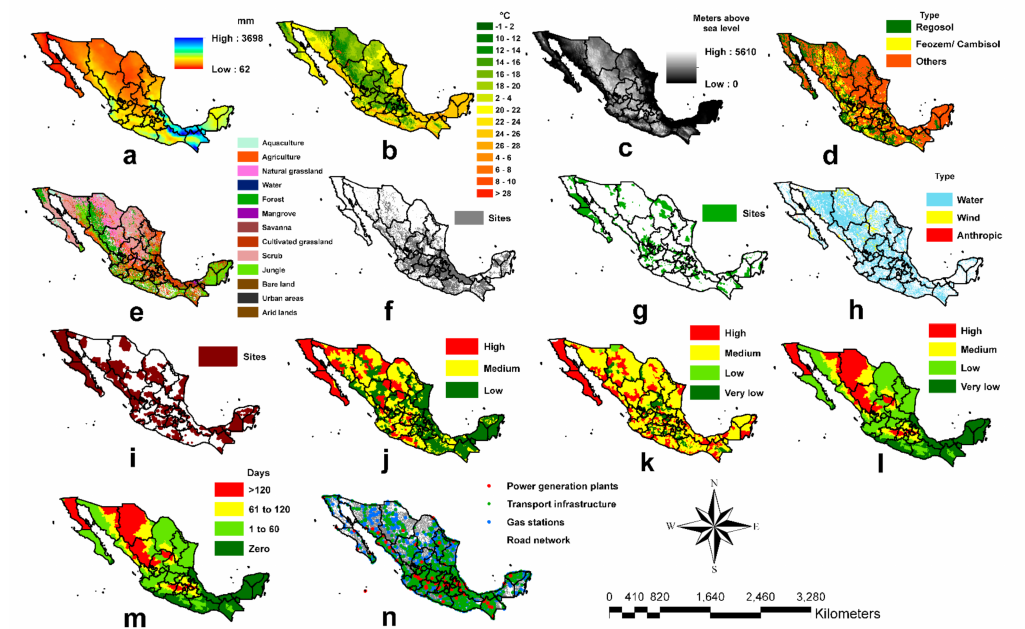
Figure 1. Input data: ( a ) rainfall; ( b )temperature; ( c ) elevation; ( d ) soil type; ( e ) land use / land cover; ( f ) food crops; ( g ) protected natural areas and RAMSAR sites; ( h ) erosion; ( i ) vulnerability to climate change; ( j ) degree of drought risk; ( k ) flooding vulnerability index; ( l ) freeze hazard rate; ( m ) frost duration in days; ( n ) socioeconomic factor. Table1. Data sets and georeferenced data layers used in the GIS-based suitability and availability analysis.